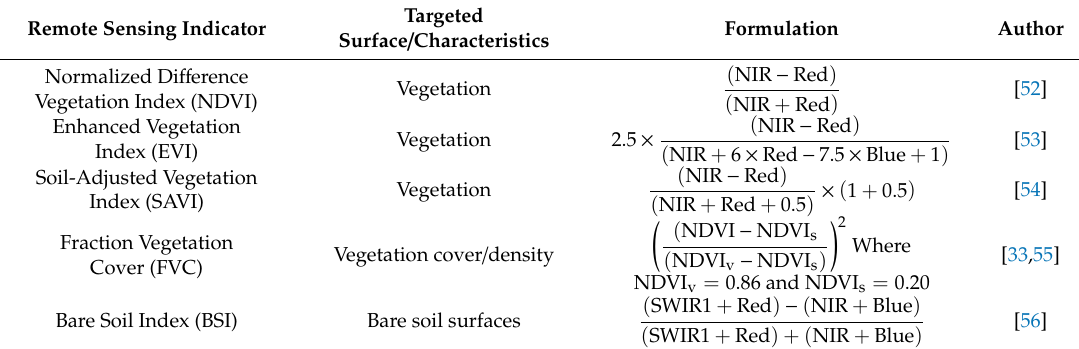
Table 3. Sentinel 2-derived remote-sensing